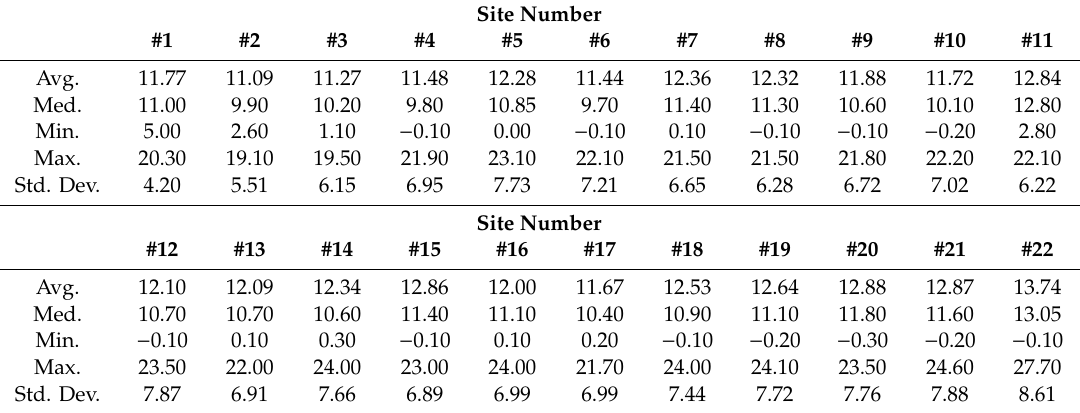
Table A2. Descriptive statistics of water temperature ( ◦ C) at each sampling location (n = 22) during study period (2 January 2018–1 January 2019) in West Run Watershed, WV, USA. Avg. = average, Med = median, Min. = minimum, Max. = maximum and Std. Dev. = standard deviation.